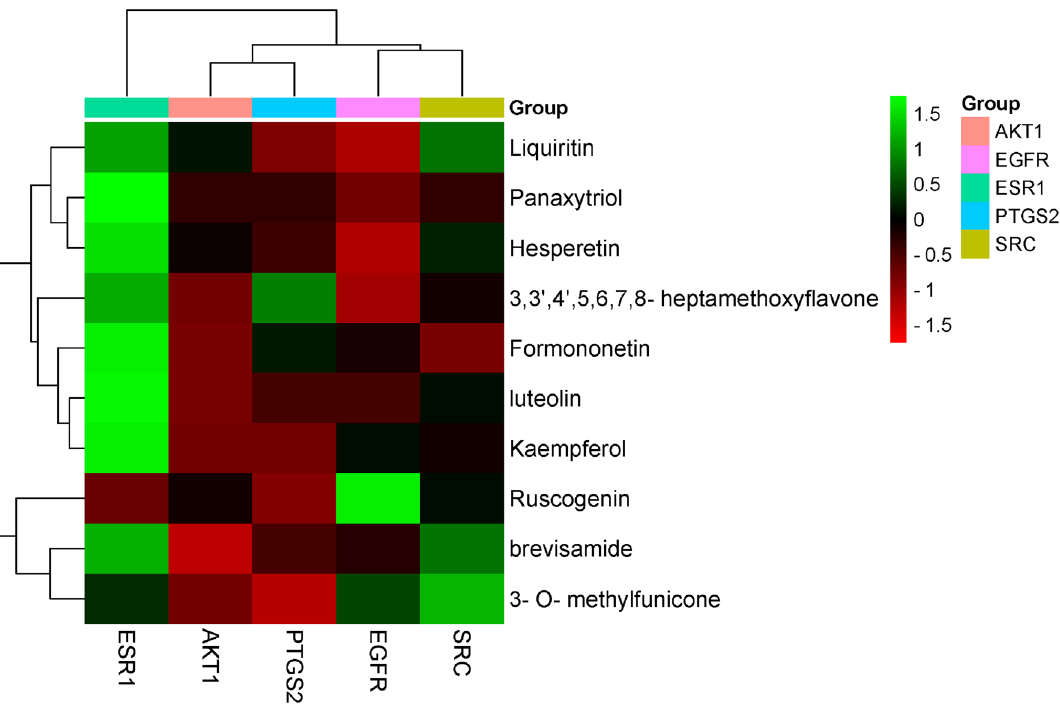
Figure 10. The binding energy of the core components with core targets [this figure was drawn by the Bioinformatics Data analysis and Visualization online platform (http:// www. bioin forma tics. com.